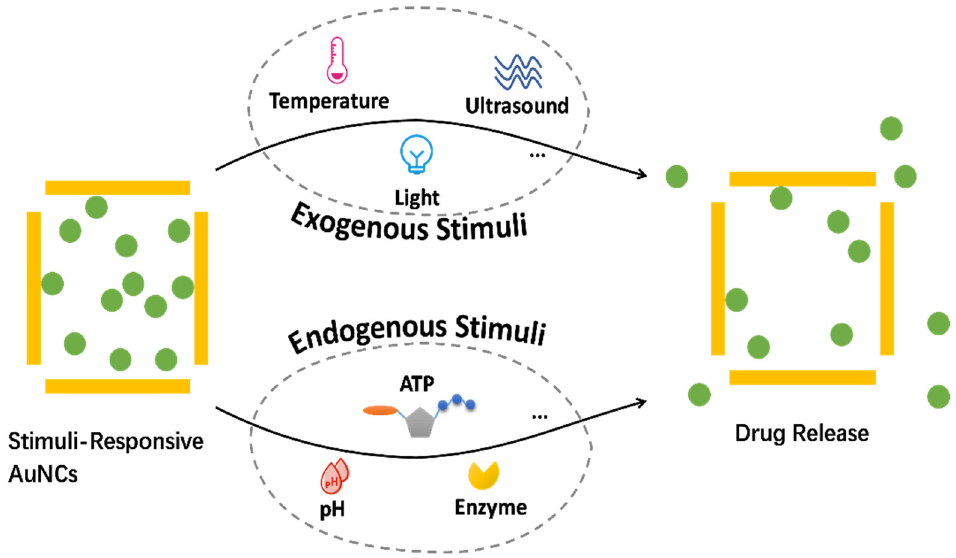
Scheme 1. Schematic illustration of stimuli-responsive